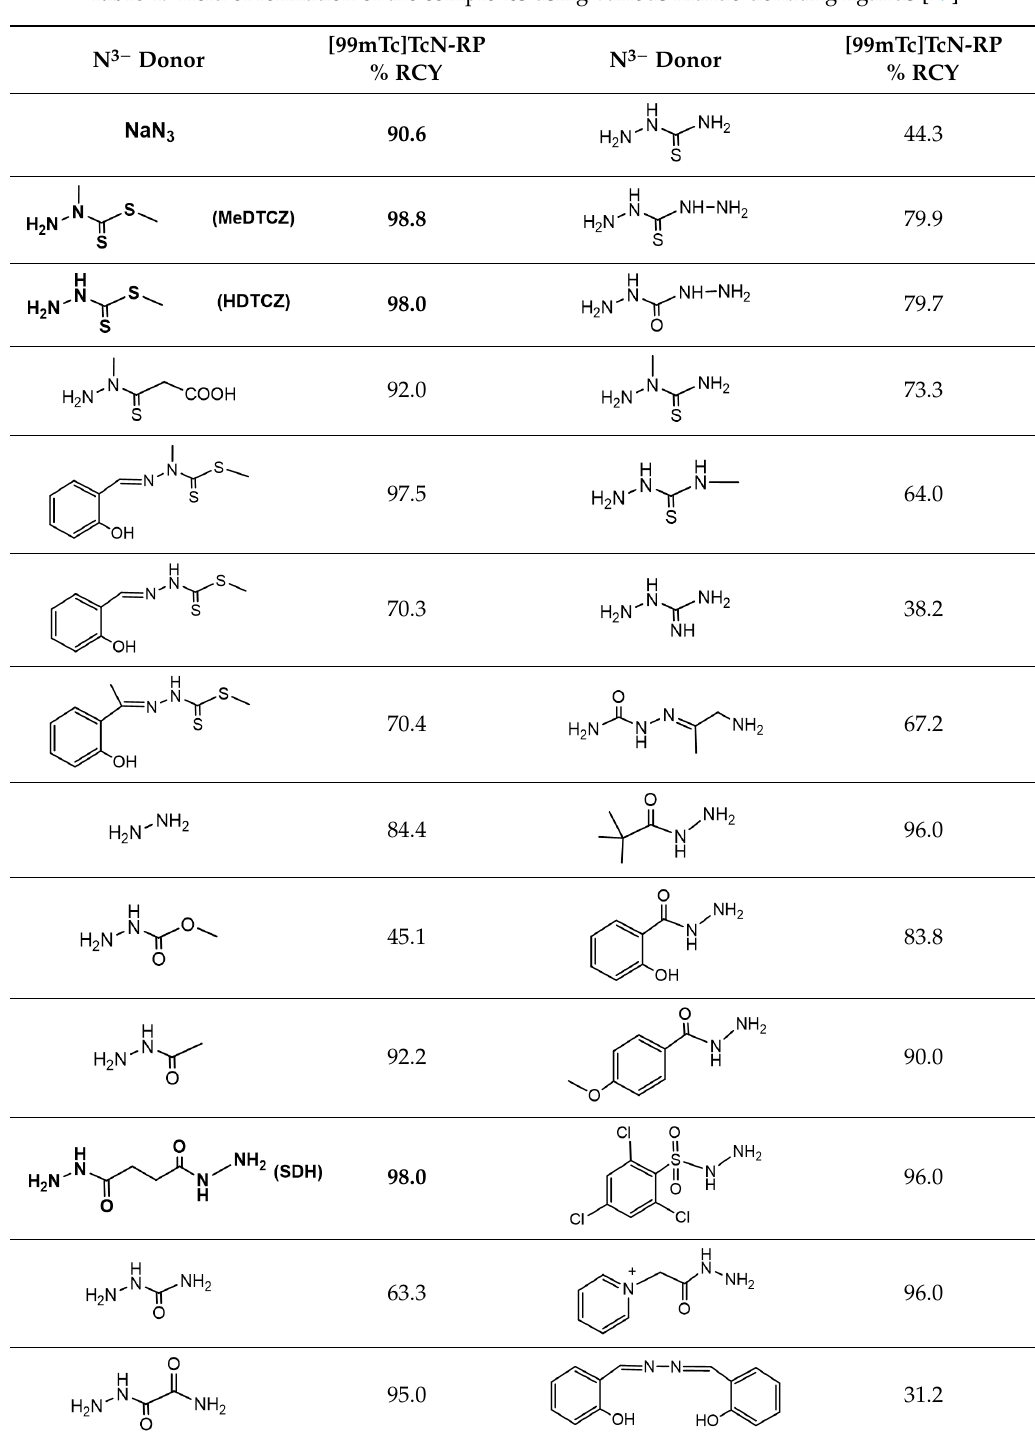
Table 4. Yield of formation of the complexes using various nitrido donating ligands [79].